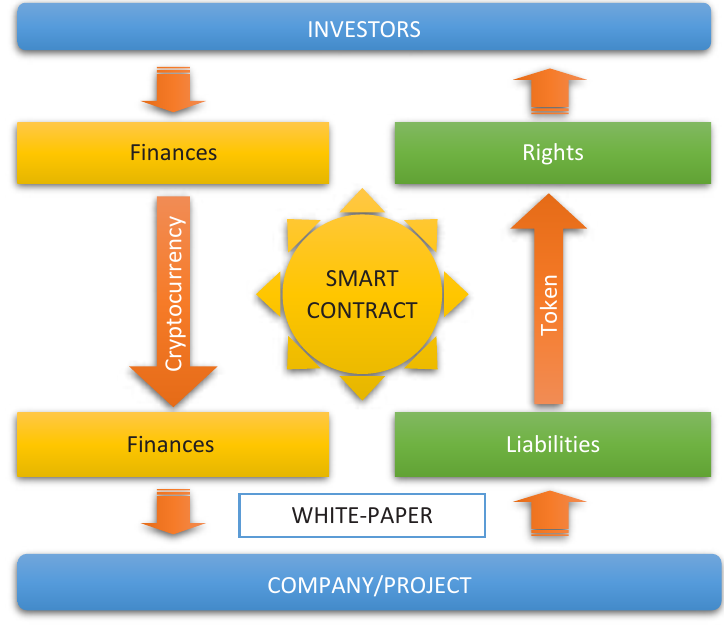
Figure 5. Generalized algorithm for attracting funding during the